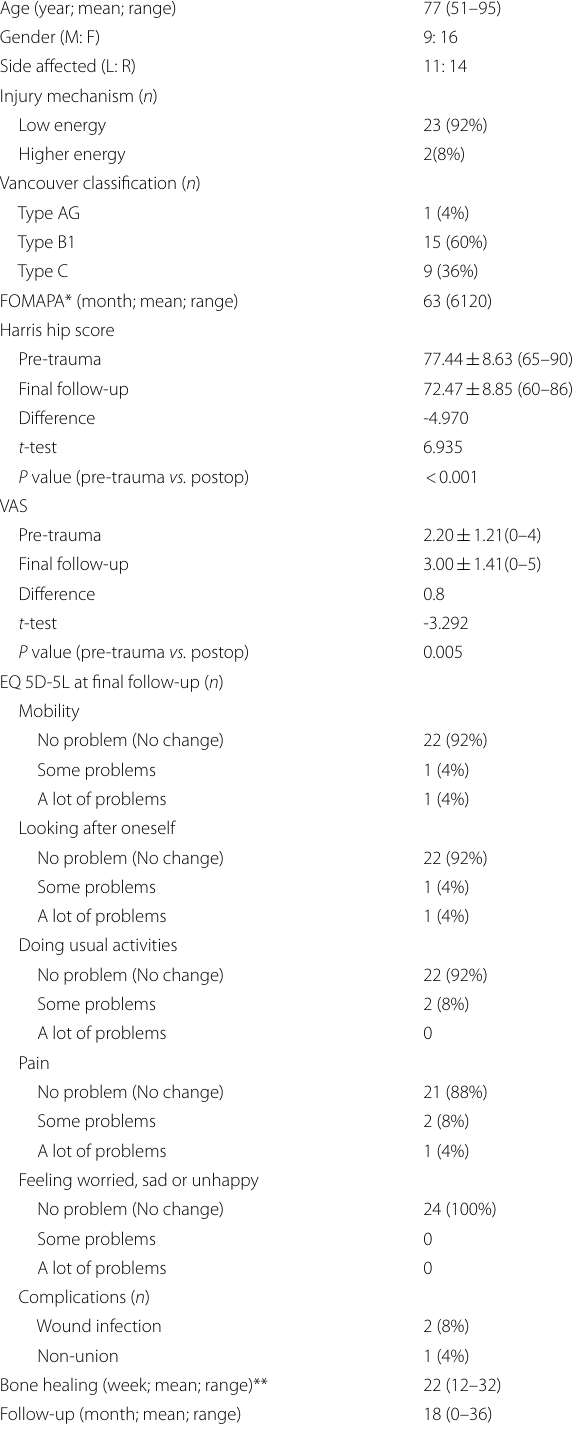
Table 1 Demographics and surgical details of 25